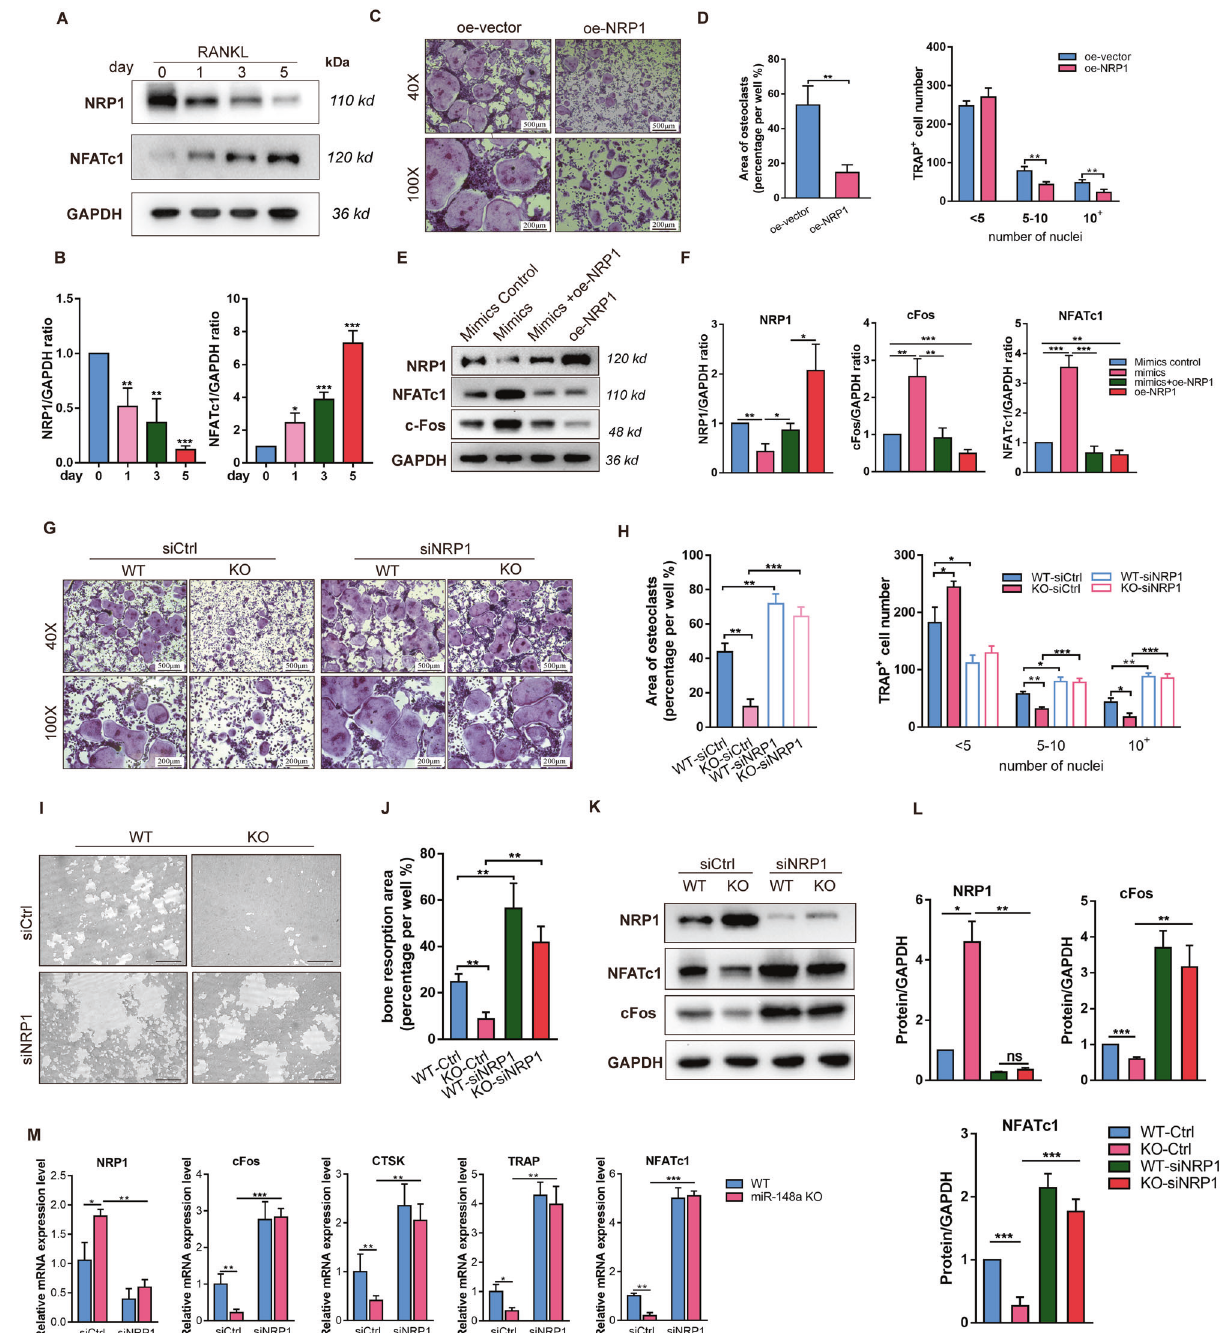
Fig. 5 miR-148a inhibits osteoclast differentiation via targeting Nrp1. A The protein expression level of NRP1 and NFATc1 during the process of osteoclast differentiation (day 0, 1, 3, 5). B Quantitative analysis of the protein level of NFATc1 and NRP1 in A , compared with the BMMs without RANKL stimulation, n = 3. C BMMs were transfected with NRP1-overexpression plasmid and vector, and then cultured in osteoclast-inductive medium containing RANKL (50 ng/mL) for 4 days. TRAP staining was performed to observe the osteoclast formation; Scale bar, 500 μ m. D Quantitative analysis of osteoclast area and TRAP-positive multinucleated cell numbers, n = 3. E , F The rescue experiments were performed in BMMs to identify the relationship between miR-148a and NRP1. Relative protein expression was quanti fi ed and presented in F , n = 3. G TRAP staining to detect osteoclastogenesis of WT and miR-148a KO cells transfected with siRNAs (siCtrl) or siRNA- targeted NRP1 (siNRP1) and cultured with RANKL for 5 days. The transfection mixture and osteoclast-inductive medium were replaced every 2 days until osteoclast could be observed; Scale bar, 500 μ m. H Quantitative analysis of osteoclast area and TRAP-positive multinucleated cell numbers, n = 3. I Representative images for bone resorption by osteoclasts; Scale bar, 200 μ m. J Quantitative analysis of bone resorption pit area per view; n = 3. K The protein expression of NRP1, NFATc1, and c-Fos in osteoclasts derived from WT and miR-148a KO mice that were transfected with the siCtrl or siNRP1. L Quantitative analysis of the protein level of NFATc1, c-Fos, and NRP1 in K ; n = 3. M The osteoclast- related gene expression of Nfatc1 , c-Fos , Ctsk , Trap , and Dc-stamp were determined by RT-qPCR; n = 3. (All data are presented as mean ± SD; * p < 0.05; ** p < 0.01; *** p < 0.001; ns no signi fi cance, compared to the corresponding control group).